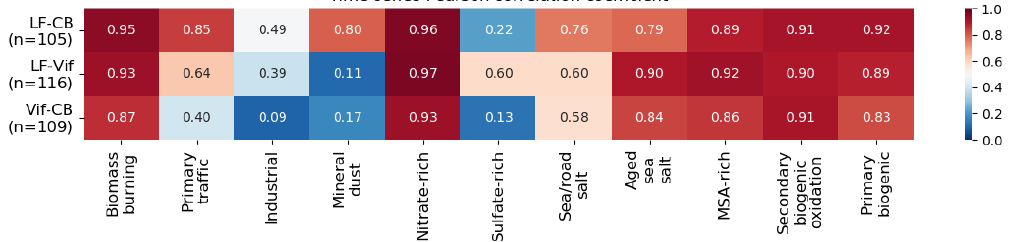
Figure 8. Heat map of the time series Pearson correlation coefficient of all factor contributions between LF and CB (LF-CB), LF and Vif (LF-Vif), and CB and Vif (CB-Vif).